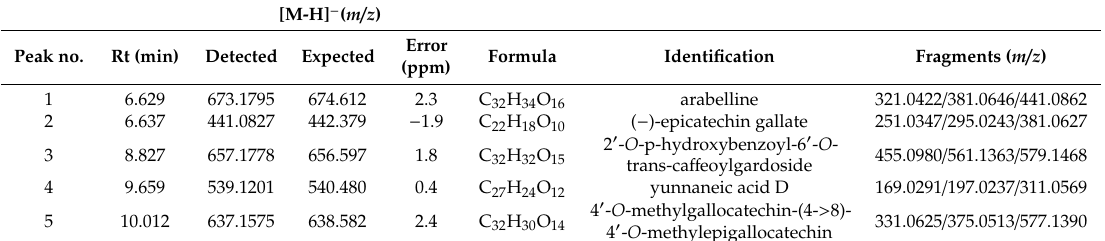
Figure 1. The chromatogram of IPA isolated from ABSC. Table 1. HPLC-Q-TOF-MS characterization of main compounds in IPA from ABSC